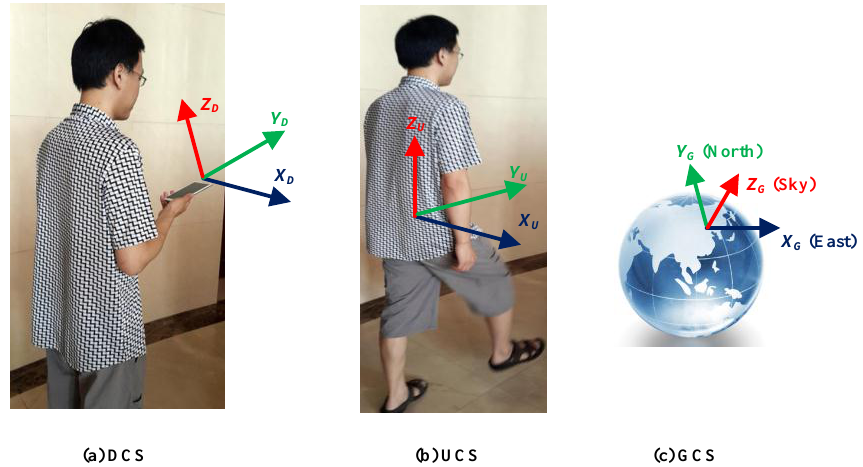
Figure 3. Definitions of three coordinate systems: ( a ) device coordinate system (DCS); ( b ) user coordinate system (UCS); and ( c ) global coordinate system (GCS).